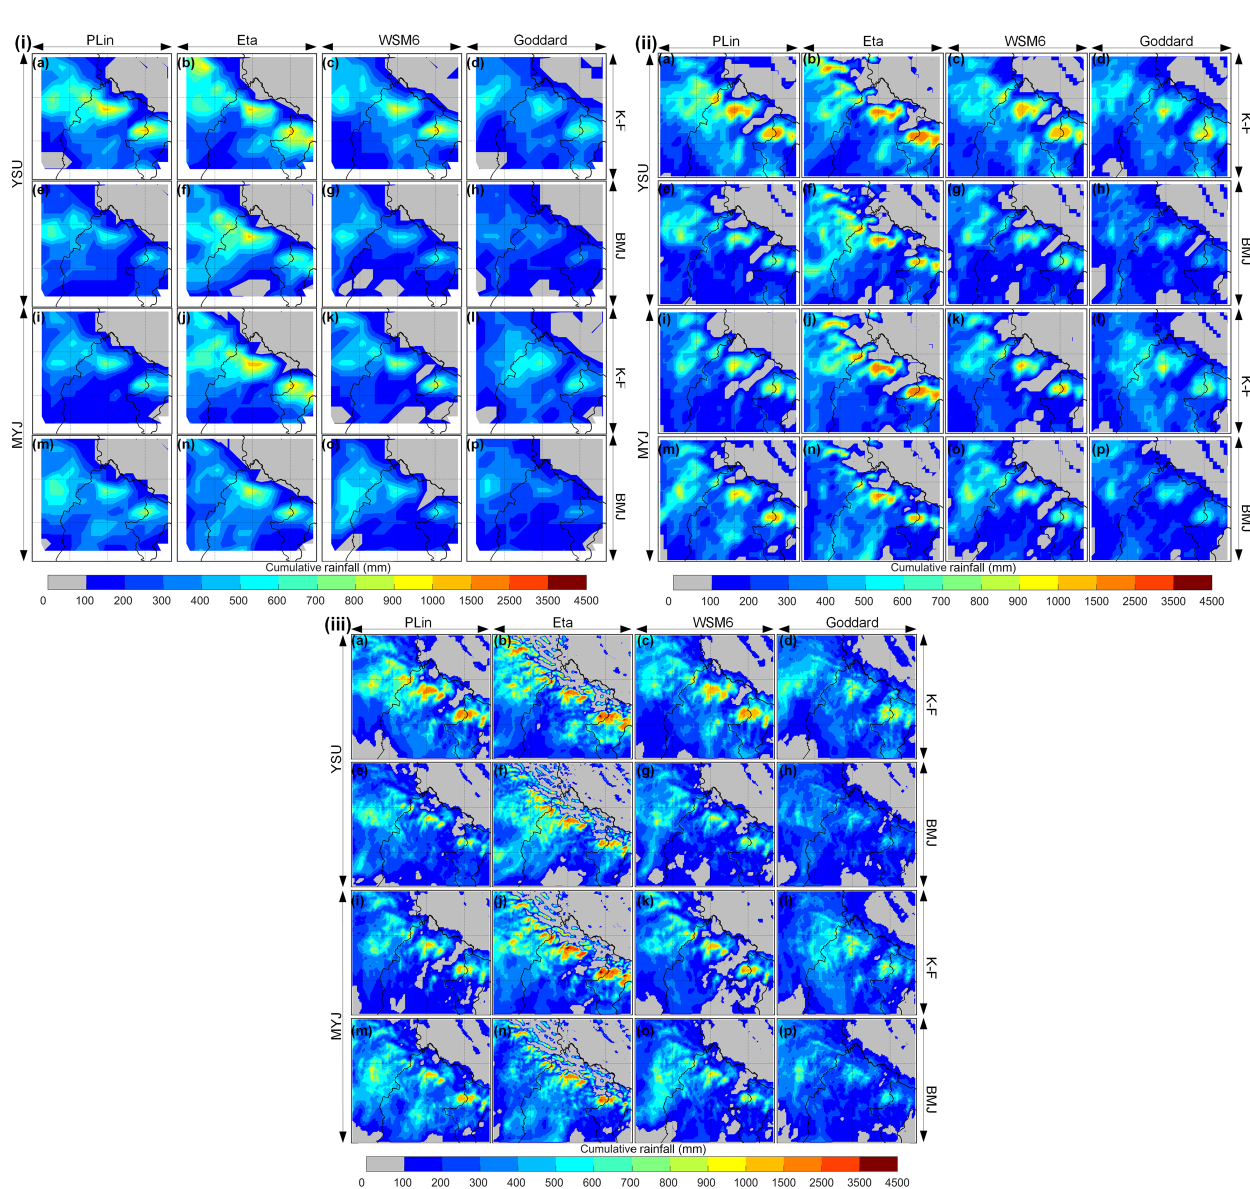
Figure 5. Spatial plots showing rainfall estimates obtained for (i) Domain 1, (ii) Domain 2a and (iii) Domain 2b. Arrows on the left indicate the PBL scheme, arrows on the right represent the CU scheme and the top arrows represent the MP scheme considered for the simulation runs. Subpanels (a) to (p) are the WRF configurations; for instance, (a)–(i) represent the WRF configuration with the YSU PBL scheme,